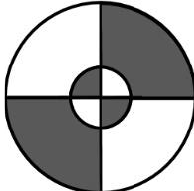
Figure 20. A general view of the test tag. Based on the known dimensions of the test tag and the Edge Hipass 5 × 5 filter, the camera was calibrated to establish the scale (the relationship between the image resolution of 800 × 600 pix and the observed view in millimeters—Figures 21 and 22). The calculated scale was 0.212 mm/pix.